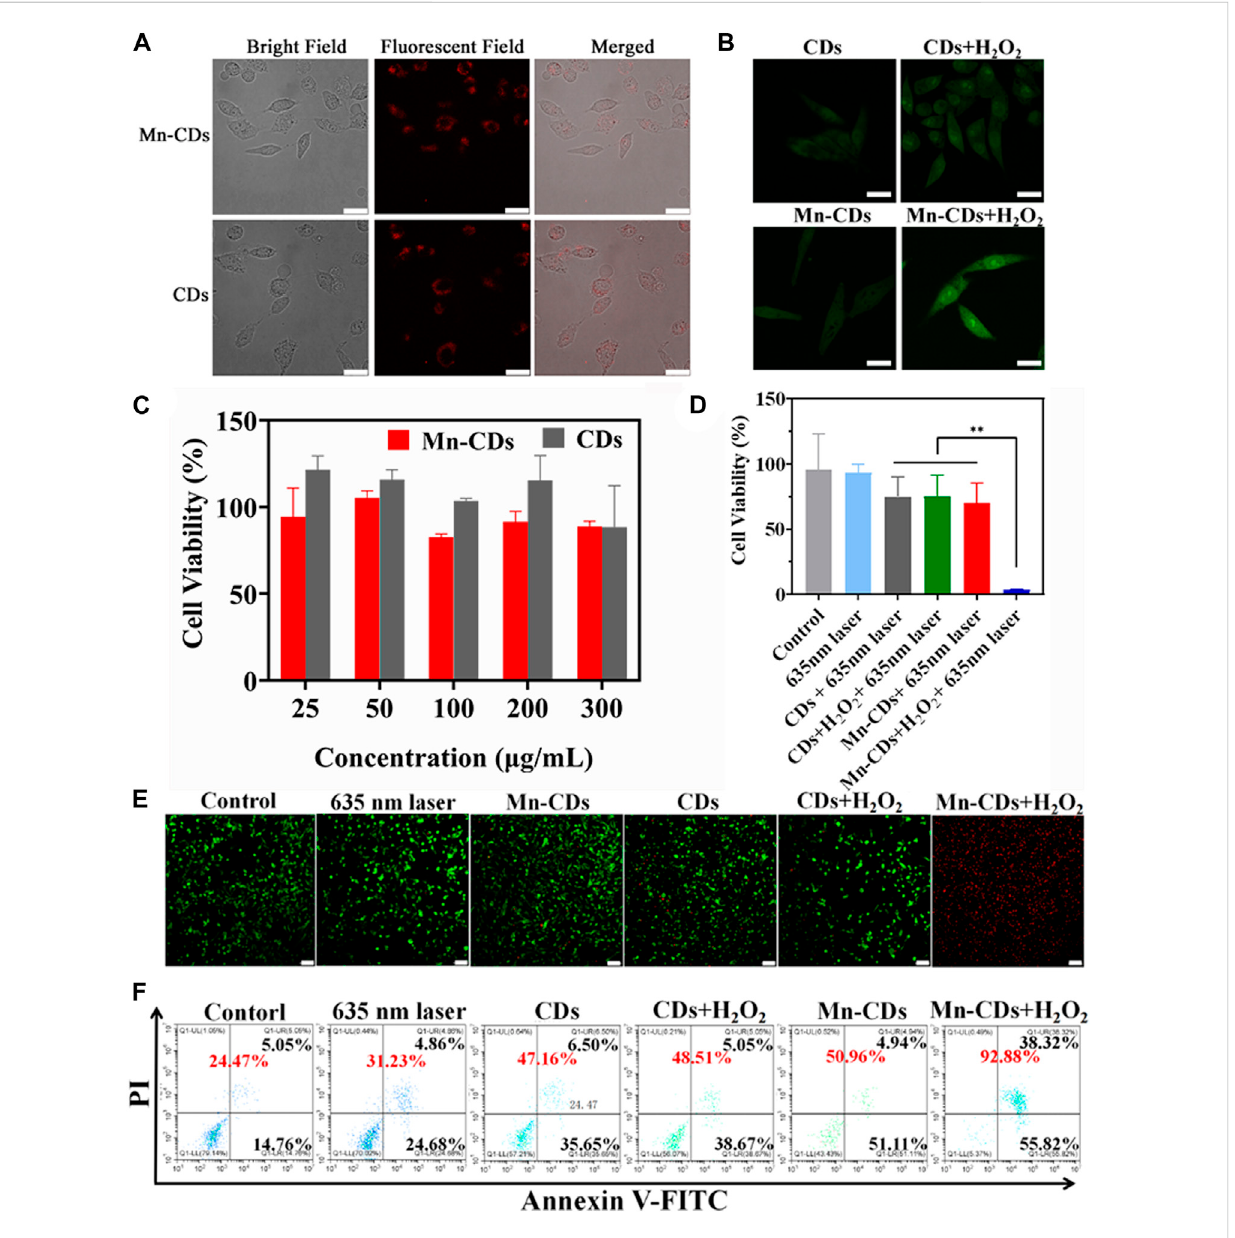
FIGURE 3 Invitro PDTef fi ciencyof Mn-CDsandCDs. (A) Cellular uptakeofMn-CDsandCDs(Scalebar:10 μ m). (B) FLimagesof SOSG-stainedOSCC-9 cells(Scale bar: 10 μ m). (C) Cell viability of OSCC-9 cells incubated with Mn-CDs and CDs with different concentrations under the dark. (D) Cell viability of OSCC-9 cells treated with Mn-CDs and CDs with or without H2O2 under 635 nm laser irradiation (300 mW · cm − 2 ). (E) The images of OSCC-9 cells co-stained by Calcein AM andPIafterdifferenttreatments(Scalebar:100 μ m). (F)